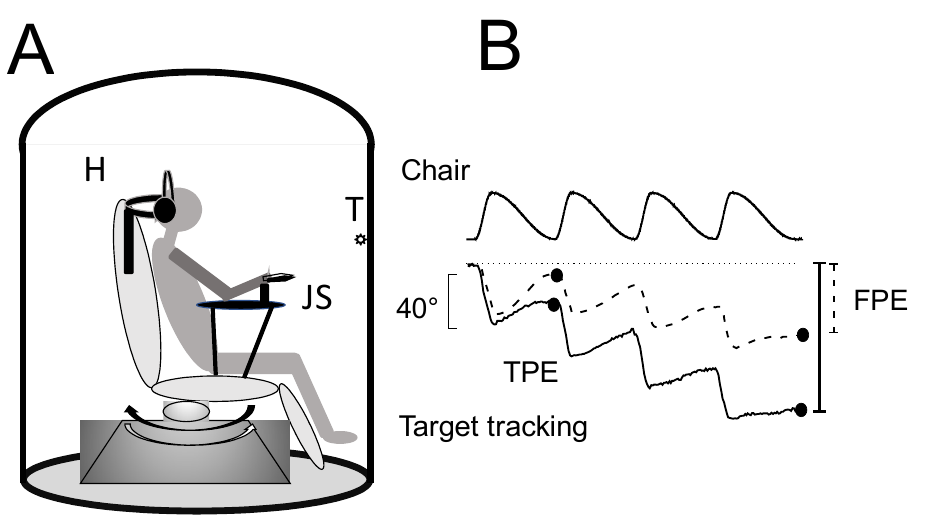
Figure 1. ( A ) Schematic drawing of the experimental setup. H: holder that keeps the head, trunk, and pelvis in place during cyclically imposed whole-body yaw rotations produced by rotation of the chair; JS: joystick for tracking position recording; T: visual target. Solid and outlined arrows indicate fast and slow rotation, respectively. ( B ) Tracking of perceived body motion in response to asymmetric chair rotation before (dashed line) and after (entire line) conditioning. Black spots indicate tracking position error (TPE) and final position error (FPE).